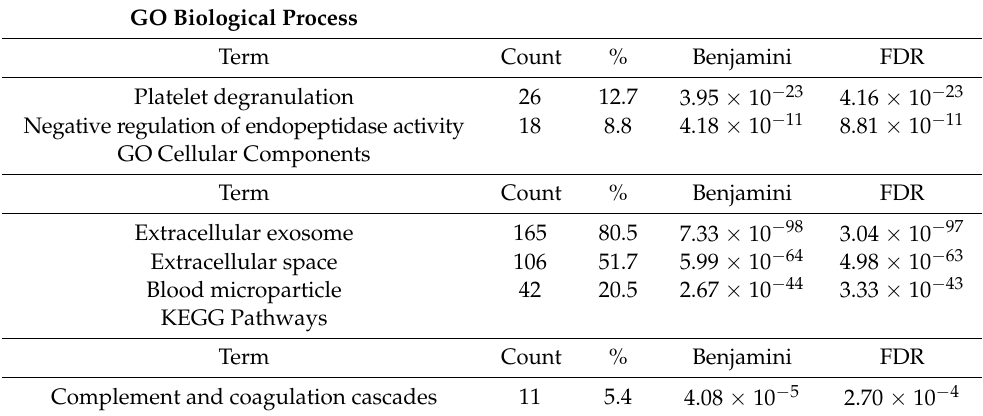
Table 5. Gene ontology (GO) categories and KEGG pathways enriched by commonly expressed proteins (250) between control (CON), yeast culture (YC), and Oat sows on days 7 and 14 of lactation. FDR = false discovery